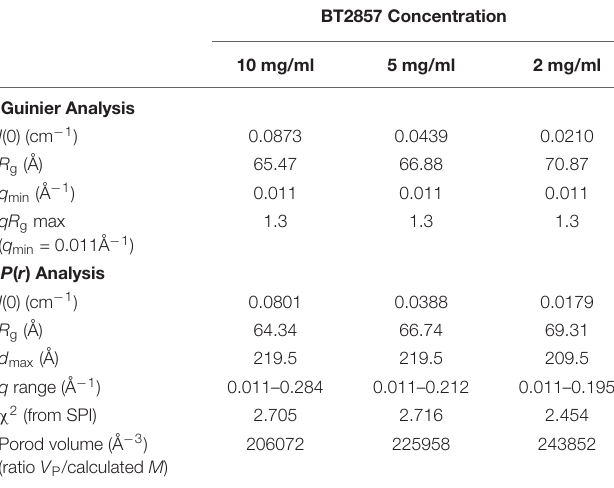
TABLE 2 | BT2857 SAX data analysis and model